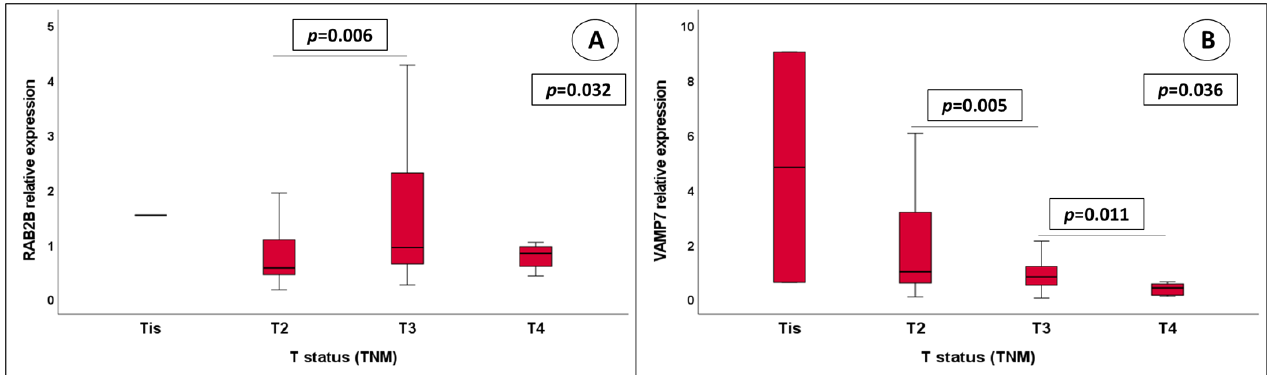
Figure 4. Relative gene expression of RAB2B ( A ) and VAMP7 ( B ) with regards to T status (n = 109). Higher RAB2B relative expression is observed in T3 tumors compared to T2. VAMP7 relative expression is decreasing as T status increases, with T3 tumors having lower expression than T2 tumors and T4 tumors having lower expression than T3 tumors.